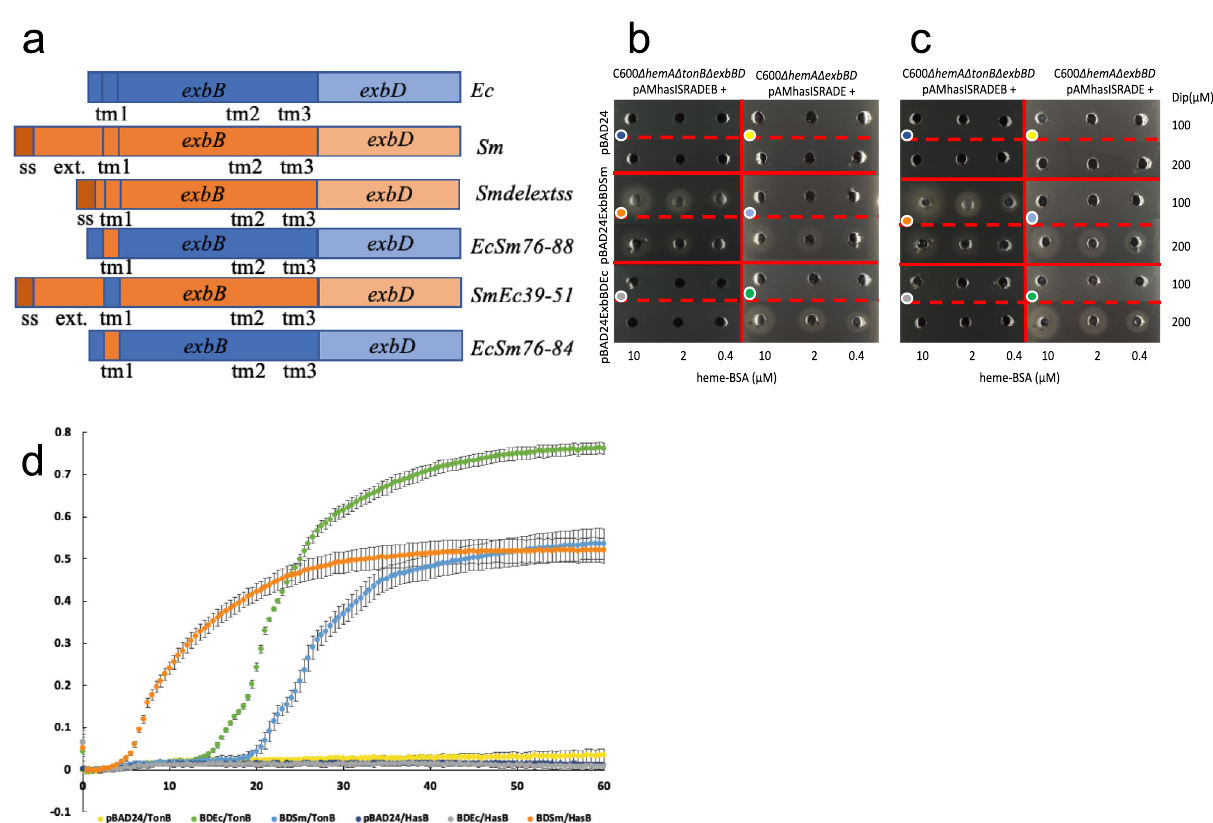
AUTHOR New Figure 3: